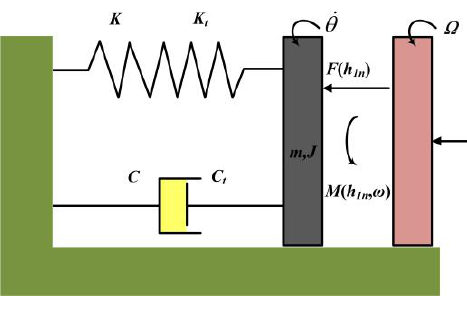
Figure 4. Dynamic model.